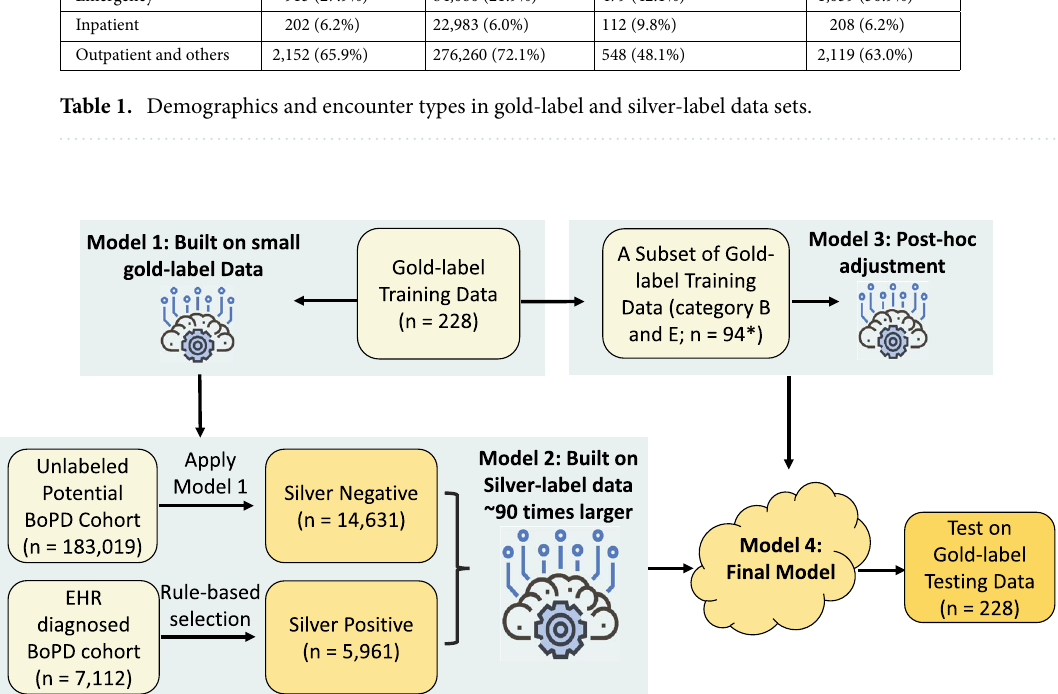
Figure 1. The ML model development pipeline which follows a semi-supervised learning framework by starting with small gold-label data, and then building a large silver-label data; an adjustment model was built to reduce false positives. Details can be found in the Methods section. *Refer to the Table 3 for the label